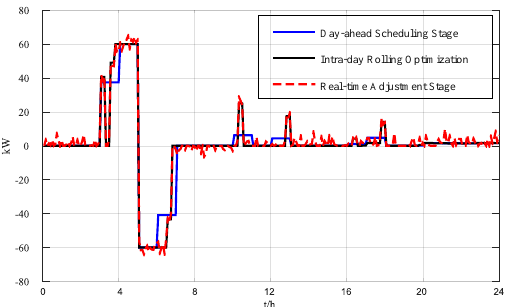
Figure 7. Battery charge and discharge power at multiple time scales.